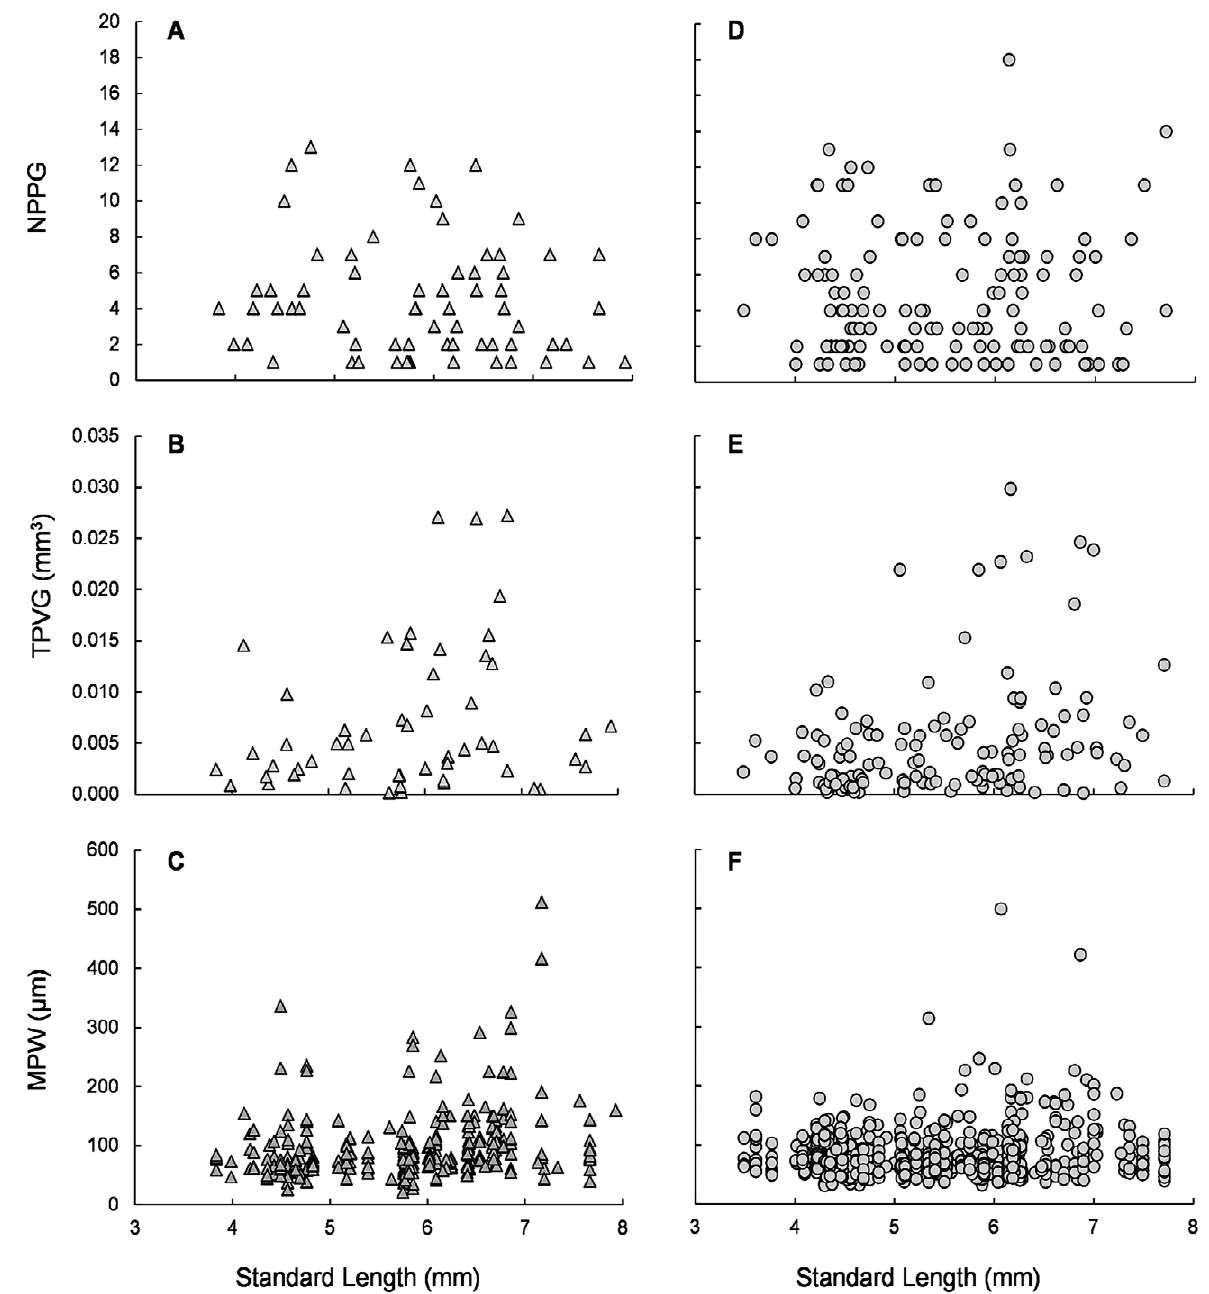
Fig 5. – Feeding success of larval sandperch measured as number of prey per gut (NPPG, number), total volume per gut (TVPG, mm 3 ) and maximum prey width (MPW, μm), and its variation with standard length (mm). Left panels, Prolatilus jugularis (triangles) ; right panel, Pinguipes chilensis